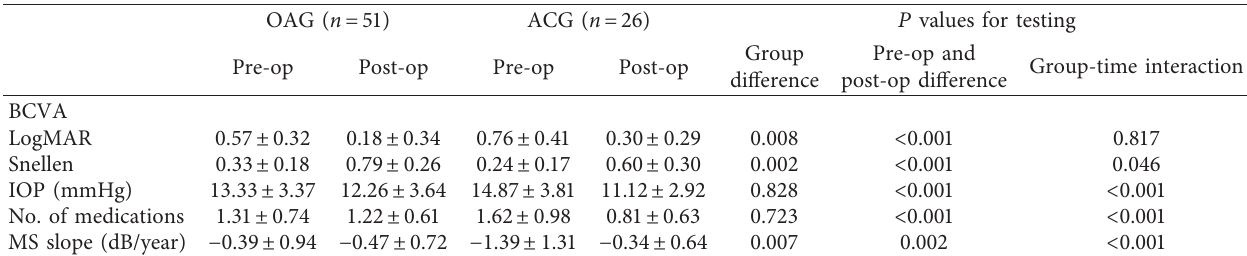
Table 3: Comparisons of ophthalmic measurements between two groups, before and after cataract